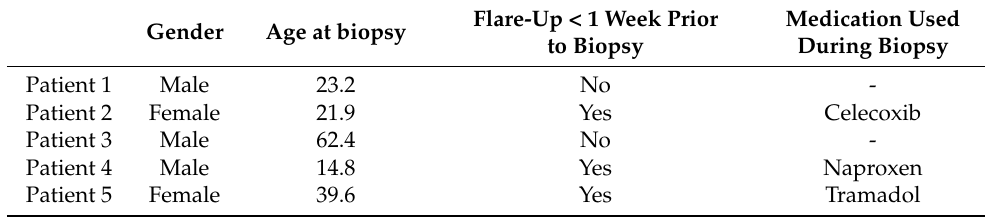
Table 1. Overview of clinical characteristics of FOP